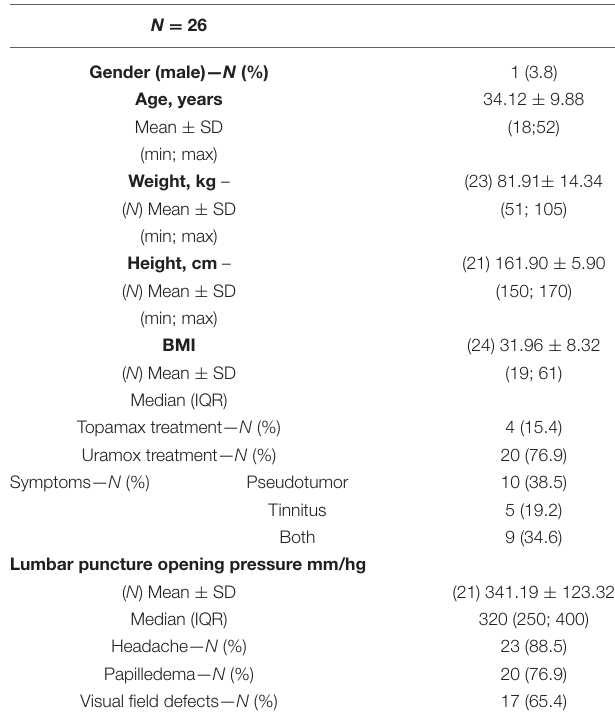
TABLE 1 | Patient demographics and clinical